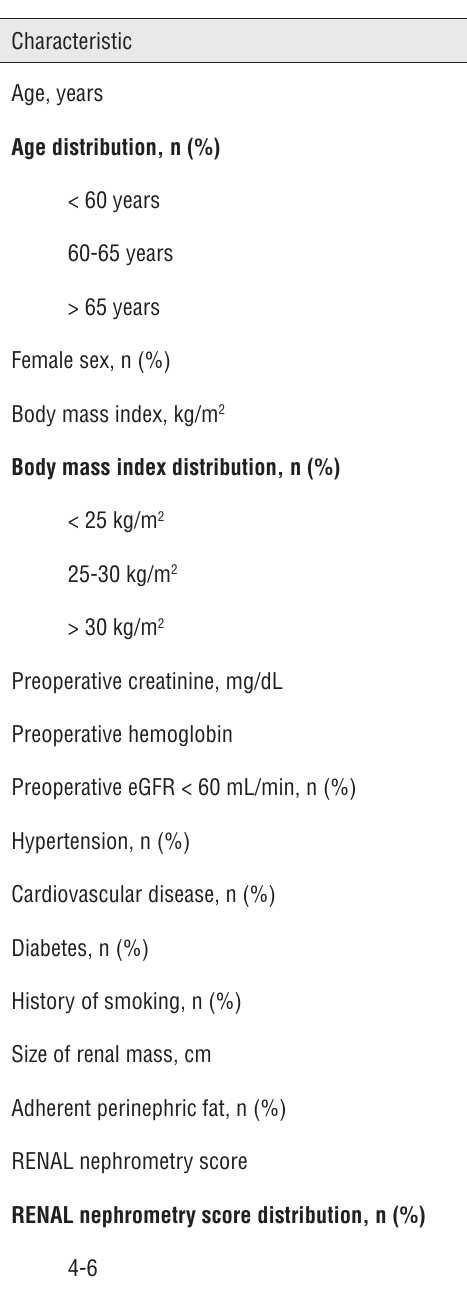
Table 1 - Patient and renal mass